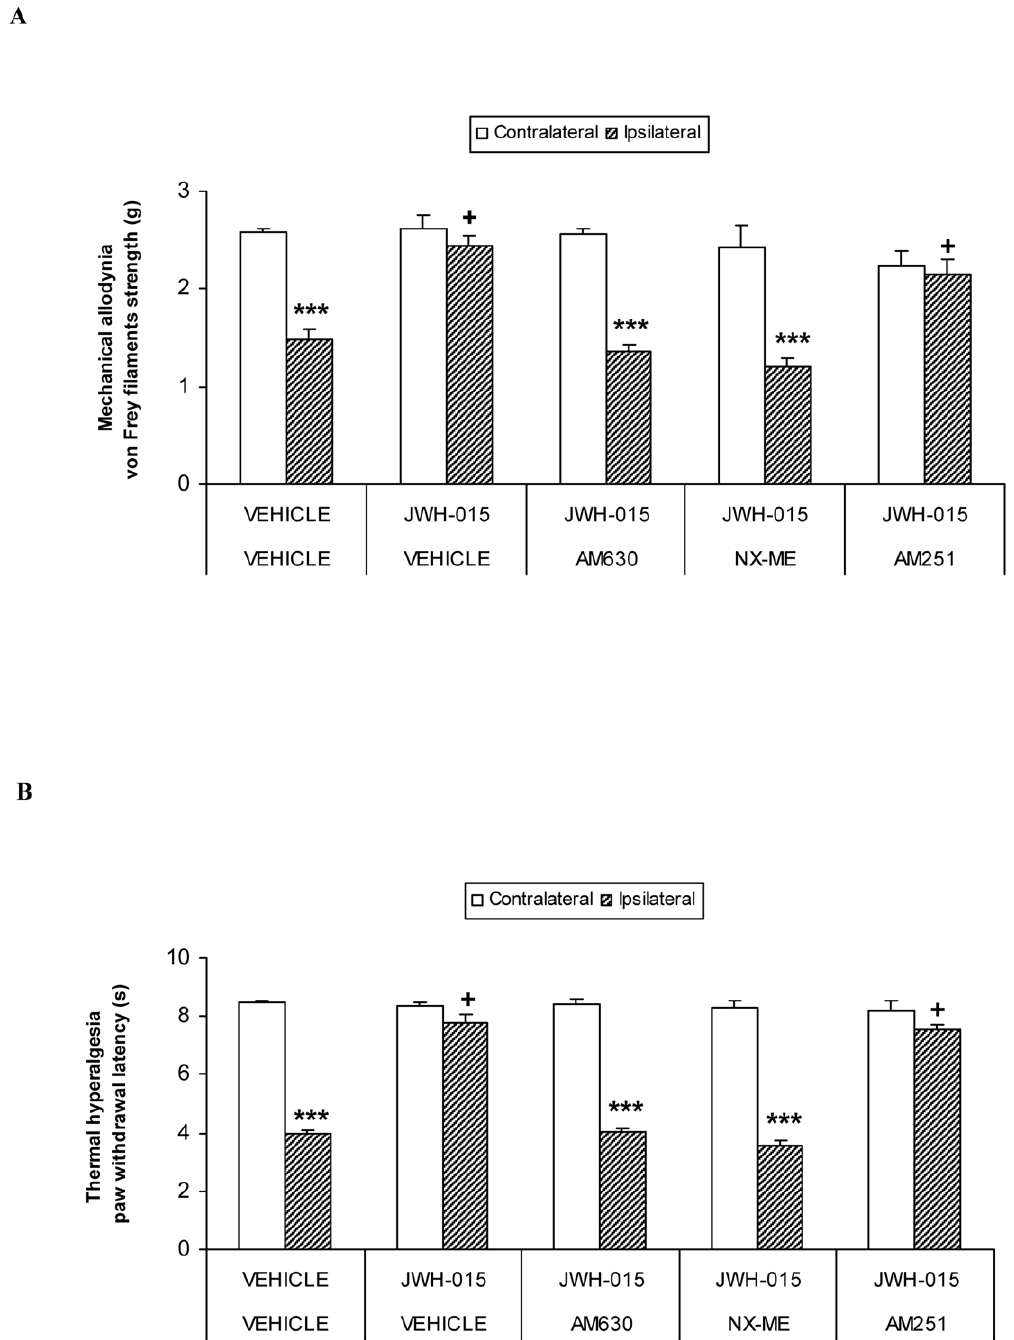
Figure 2. Reversion of the antinociceptive effects of JWH-015. Effects of the subplantar administration of vehicle, AM630 (60 m g), NX-ME (150 m g) or AM251 (150 m g) on the inhibition of the mechanical allodynia (A) and thermal hyperalgesia (B) induced by the subplantar administration of JWH-015 (150 m g) in CFA-injected WT mice. Data are expressed as mean values of the von Frey filaments strength (g) for mechanical allodynia and as the paw withdrawal latency (s) for thermal hyperalgesia 6 SEM (5-6 animals per group). For each test and drug, *** indicates significant differences when compared to their corresponding contralateral paw (p , 0.001, paired Student’s t test) and + indicates significant differences as compared with the ipsilateral paw of the vehicle treated group (p , 0.05, one way ANOVA followed by the Student-Newman-Keuls test).